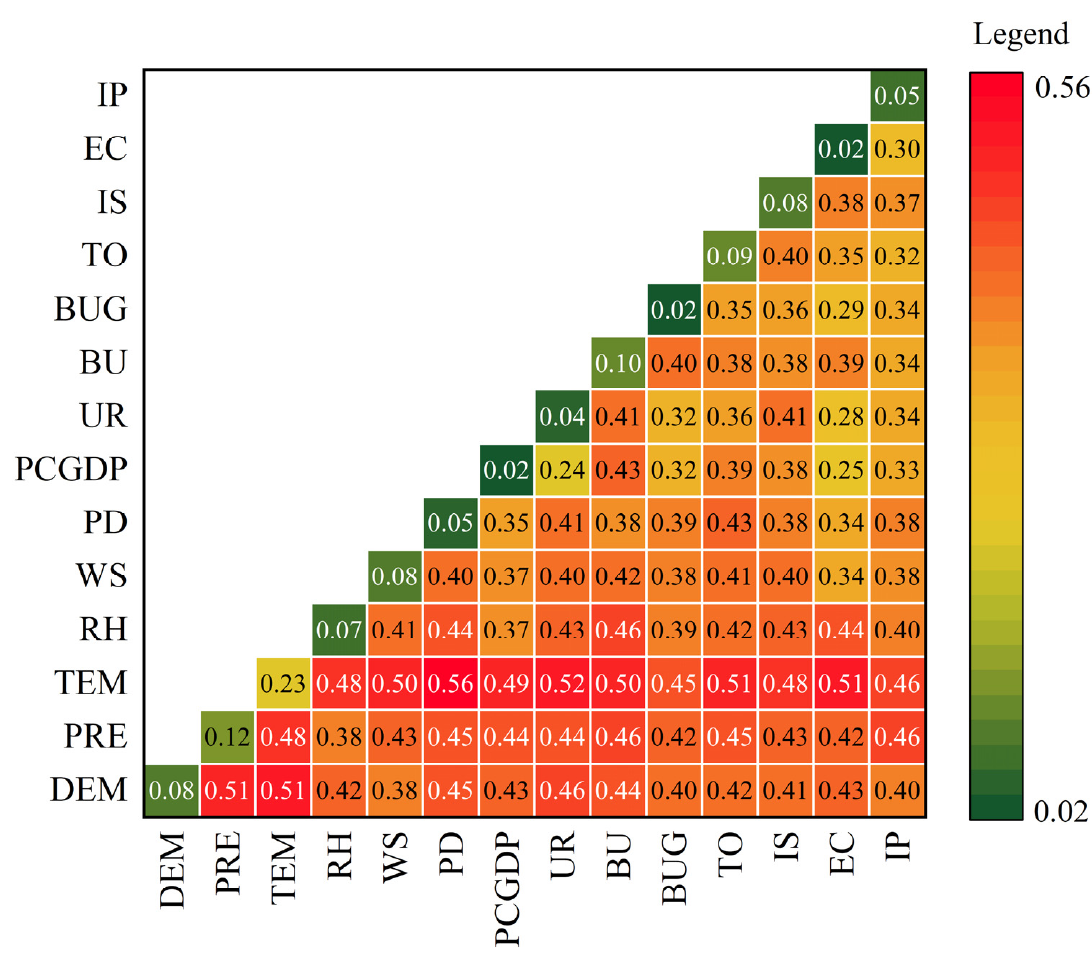
Figure 3. The results of geographical detector technique. Note: The main diagonal is the result of factor detector; others are interaction detector. All coefficients passed the significance test of 0.05. DEM: altitude; PRE: precipitation; TEM: temperature; RH: relative humidity; WS: wind speed; PD: population density; PCGDP: per capita GDP; UR: urbanization rate; BU: built-up area divided by urban area; BUG: greening area divided by built-up area; TO: trade openness; IS: the ratio of the added value of secondary industry; EC: electricity consumption; IP: invention patents.